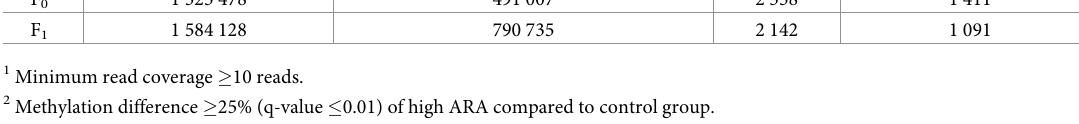
Table 1. Total methylated loci before and after filtering, number of differentially methylated loci (DML) and hyper- and hypomethylated loci in F 0 and F 1 livers fol- lowing a high ARA diet in F 0 . Total methylated loci